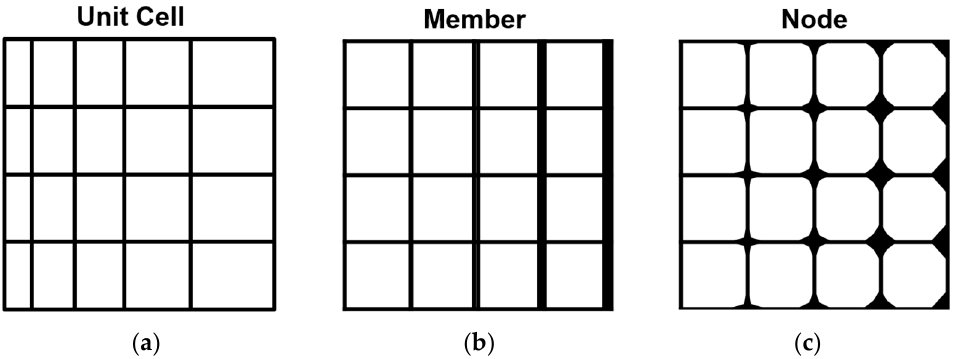
Figure 8. Gradation may be applied to one of three features: ( a ) the unit cell, ( b ) member (such as beams or walls), and ( c ) node.